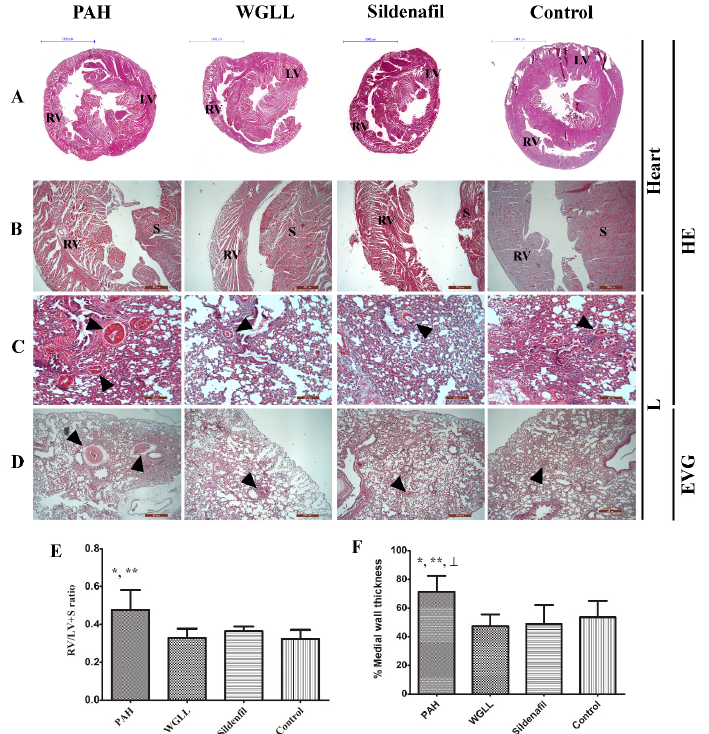
Figure 2. Outcomes of histological analyses of rats receiving four treatments: PAH (pulmonary arterial hypertension), WGLL (Wild garlic ( Allium ursinum ) liophylisate-enriched chow), Sildenafil injections, and Control. Respective figures are: ( A ) Representative images of HE-stained transversal whole heart sections, RV = right ventricle, LV = left ventricle; ( B ) HE staining of the rat hearts from short-axis slice (magnification: 40×); ( C ) Histological examination (HE staining) of lung tissues (magnification: 40×); ( D ) Elastica van Gieson (EVG) staining demonstrates the thickness of pulmonary arterial wall in lung tissues (magnification: 40×); ( E ) Right ventricular hypertrophy (RVH) shown as RV/(LV + S) ratio; and ( F ) Quantitative analysis of peripheral pulmonary arteries demonstrates the medial wall thickness (MWT) in PAH, WGLL, Sildenafil and Control groups. The medial wall thickness was calculated by the equation: % MWT = (M1 + M2)/ED × 100. Dark triangles mark the small pulmonary arteries ( B – D ). Lenght of blue scale bars on ( A ): 5000 µm; lenght of red scale bars on ( B – D ): 500 µm. Values are expressed as mean ± standard error of mean (SEM; n = 15/group). * p < 0.05 compared to Control; ** p < 0.05 compared to WGLL; ┴ p < 0.05 compared to Sildenafil.